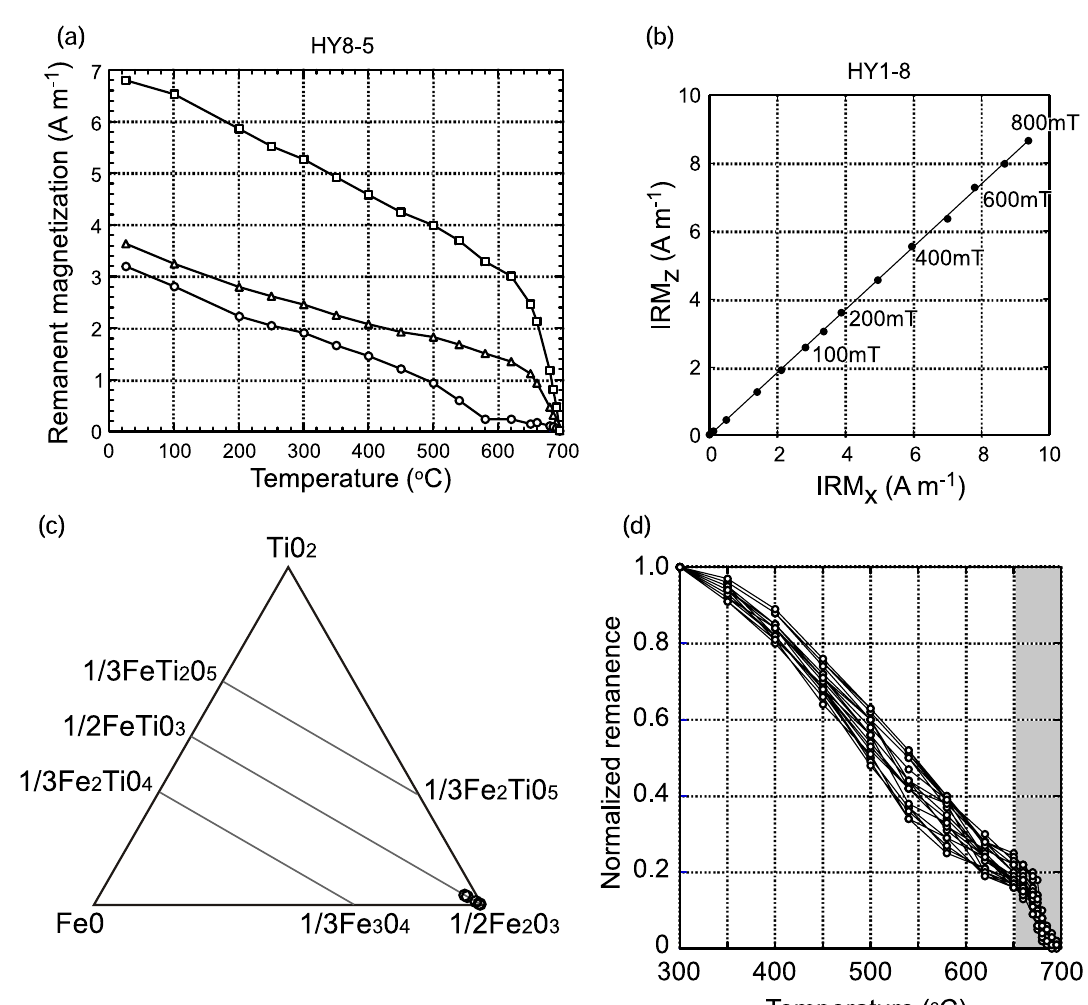
Fig. 4 a Thermal demagnetization of the orthogonal three-component IRM: circles indicate the low-coercivity component of the 0.12 T field, triangles indicate the medium-coercivity component of the 0.4 T field, and squares indicate the high-coercivity component of the 2.5 T field. b Plot of IRM Z versus IRM X showing the gradient of the best-fit correlation line, providing an estimate of the inclination shallowing in sediments. c TiO 2 –FeO–1/2Fe 2 O 3 ternary diagram showing chemical compositions of hematite grains in a sample with a laboratory unblocking temperature of 685 °C (HY4-3). Minor components are allocated as follows: